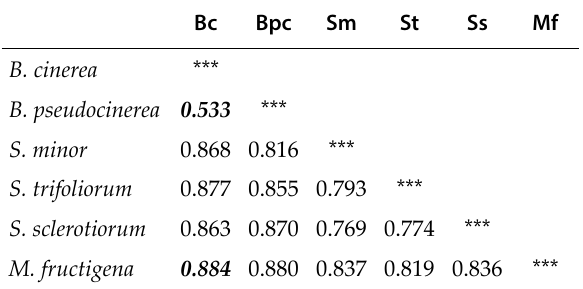
Table 5. Genetic distance matrices among six Sclerotiniace- ae species, based on iPBS retrotransposons data.